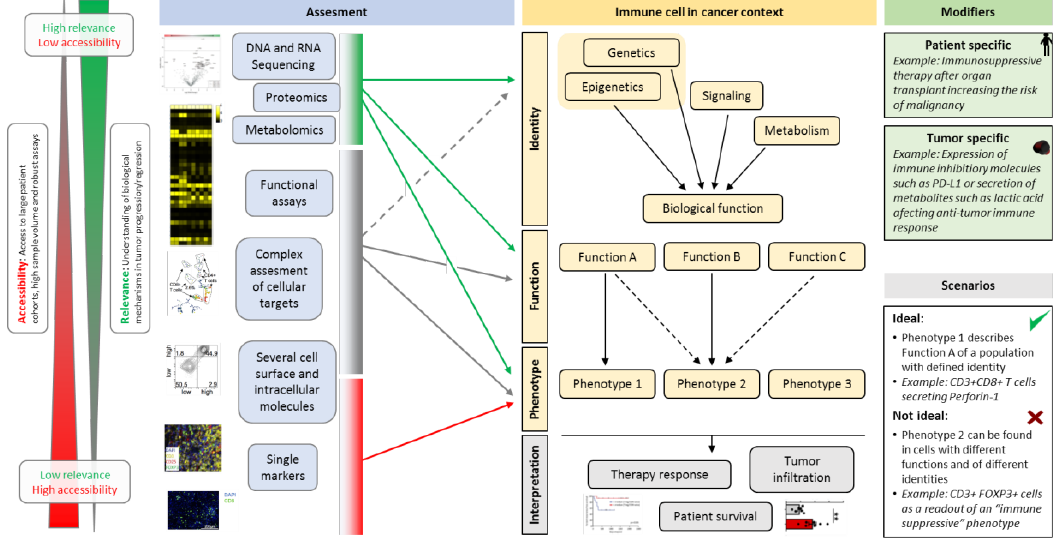
Figure 1. Overview of current tools to assess phenotype, function, and identity of immune cells in cancer. Multiple tools that differ in their accessibility, feasibility and relevance are available to